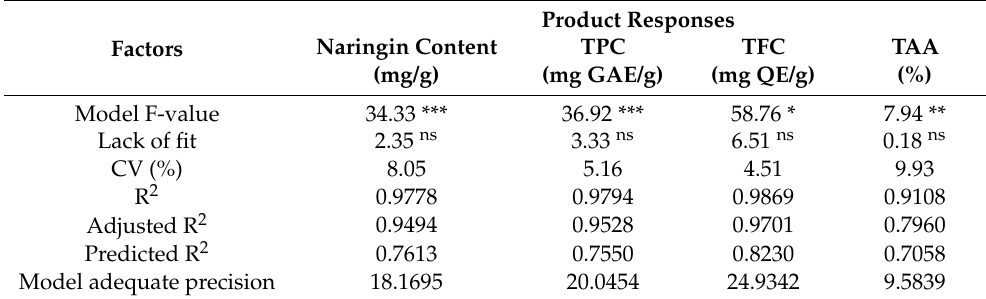
Table 3. Analysis of variance (ANOVA) table for the fit of independent factors to the response surface